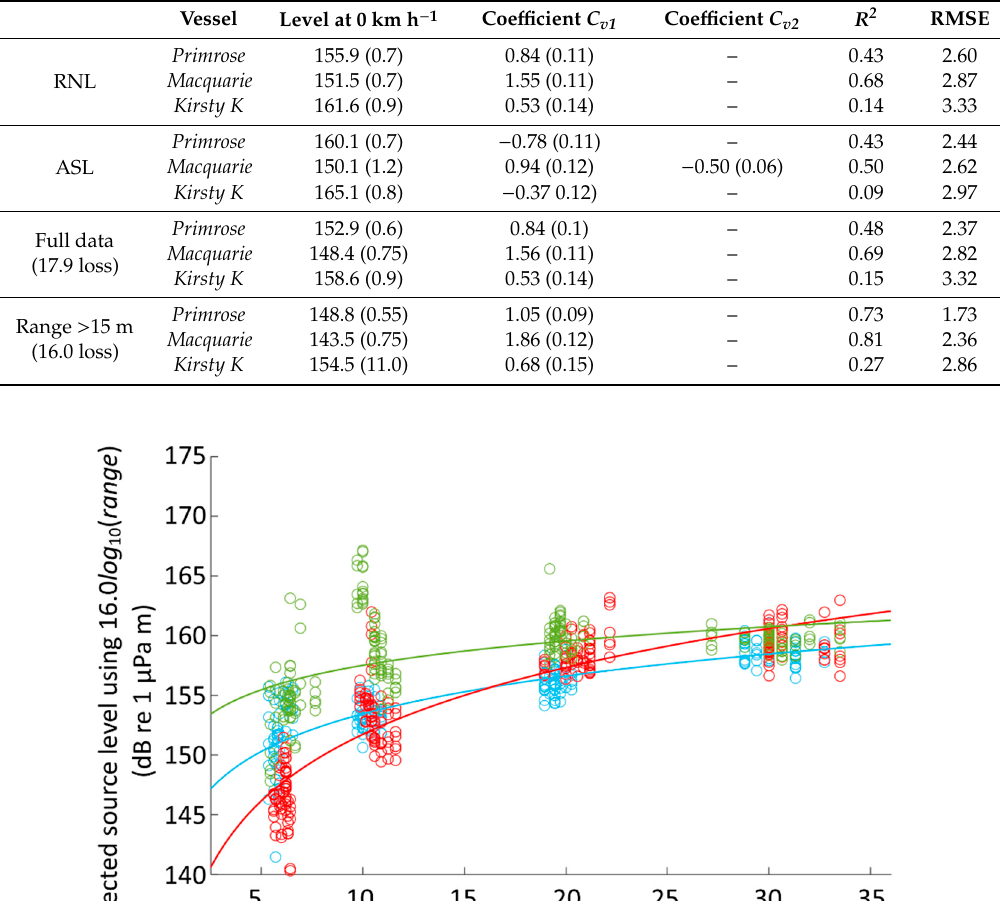
Table 5. Linear regression logistic (or polynomial for the modelled a ff ected source levels for Macquarie ) relationship between radiated noise levels, ASLs and averaged log 10 (range) ASLs with speed, showing the theoretical source level at 0 km h − 1 and remaining coe ffi cients. Standard deviations shown in parentheses.